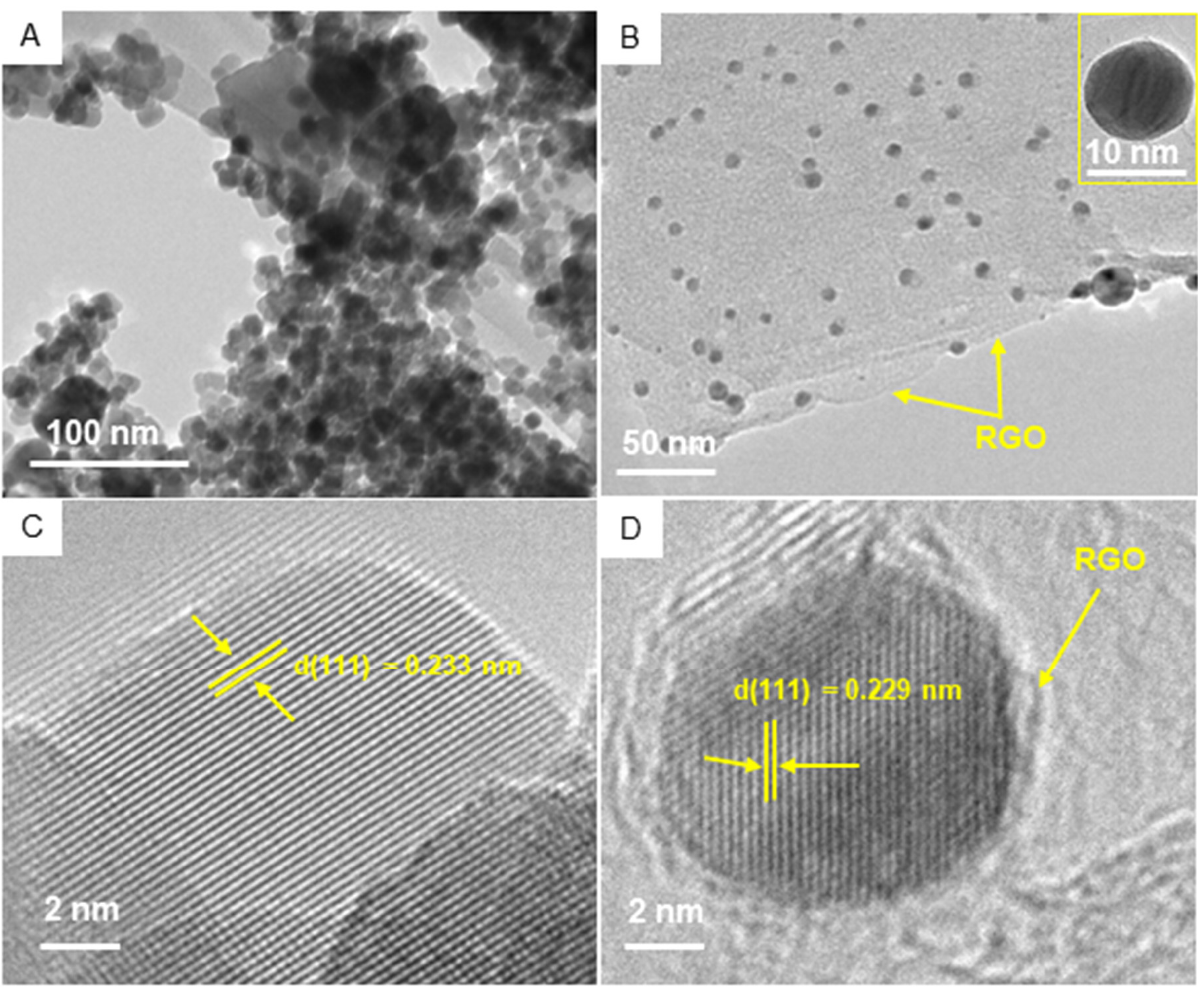
Figure 4. TEM characterization: ( A ) low-resolution TEM image of Ag NPs; ( B ) low-resolution TEM image of Ag/RGO NCs; ( C ) high-resolution TEM image of Ag NPs; ( D ) high-resolution TEM image of Ag/RGO NCs.